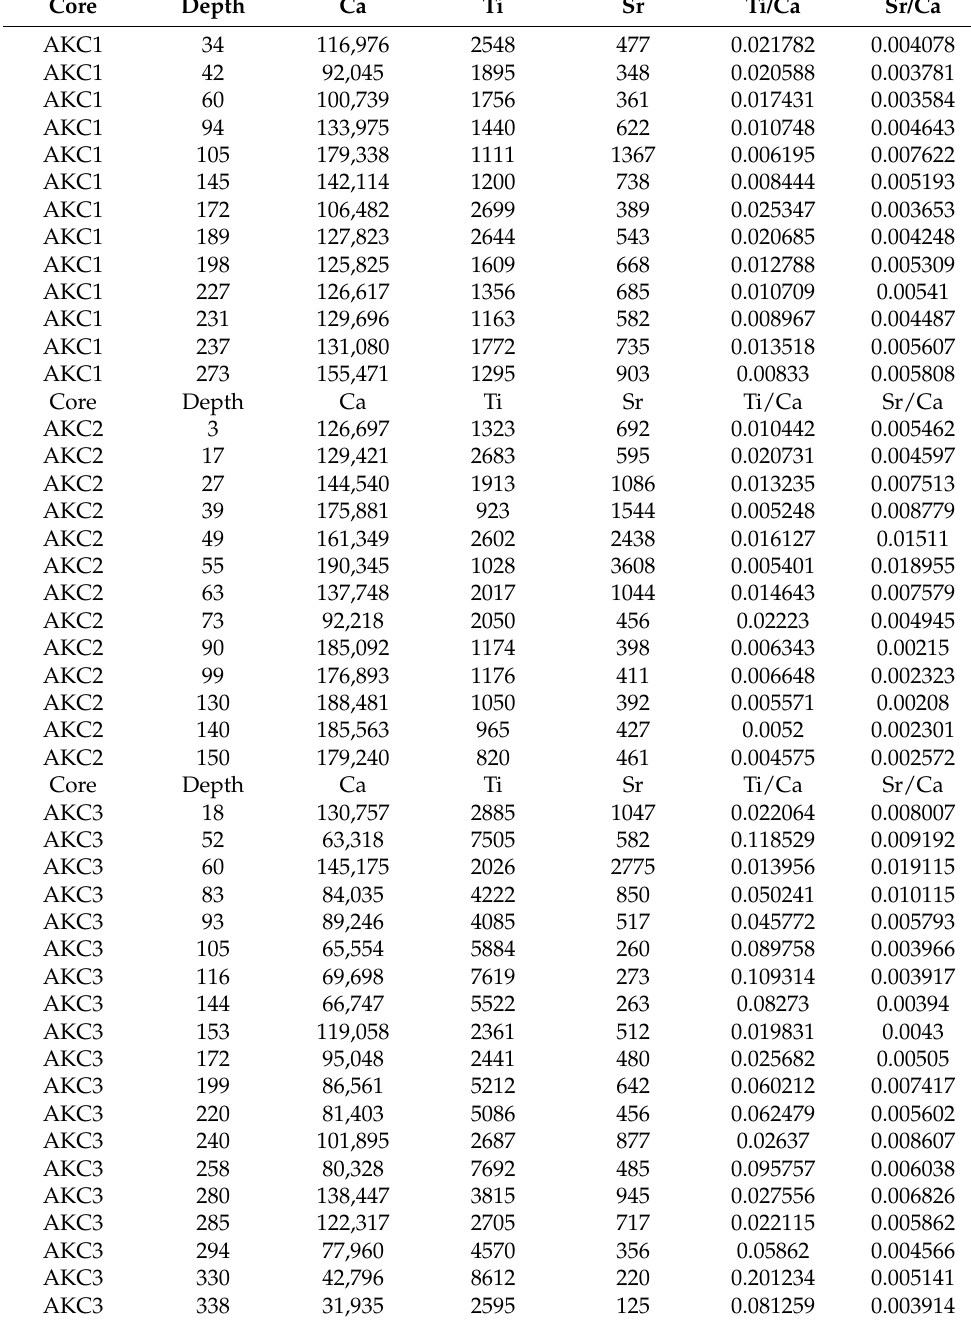
Table A3. Handheld XRF Ti/Ca, Sr/Ca